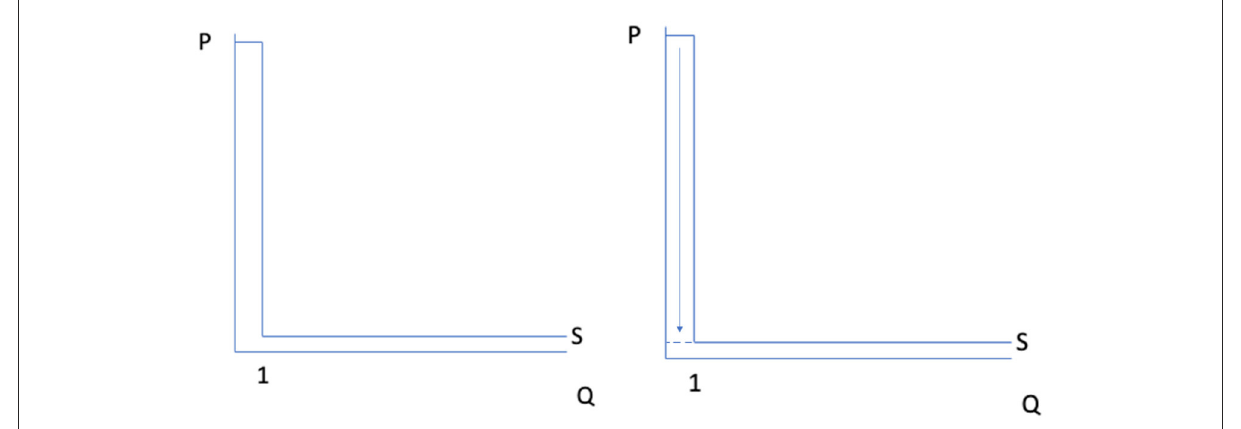
FIGURE1 Incremental and fixed costs falling toward